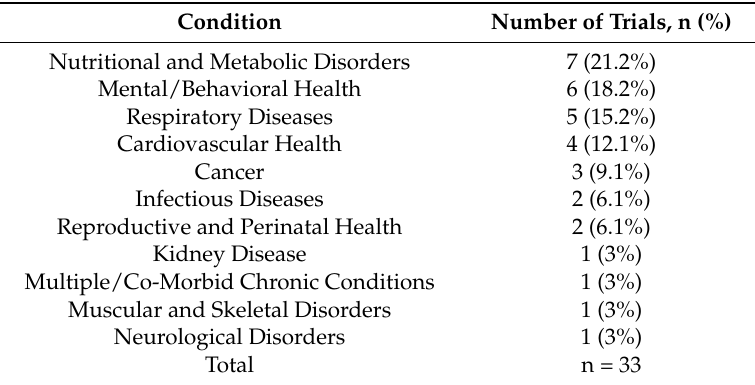
Table 2. Health conditions represented in the analysis.